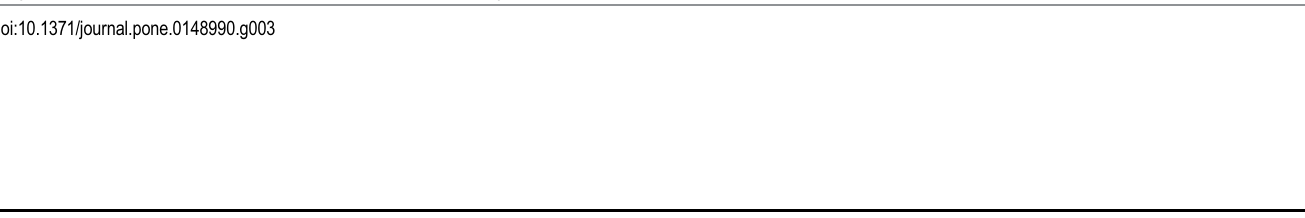
PLOS ONE | DOI:10.1371/journal.pone.0148990 February 10,